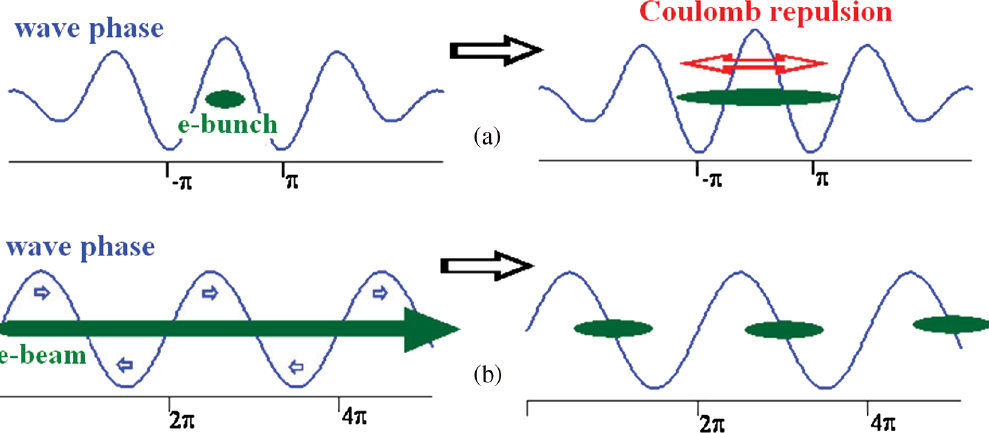
FIG. 1. (a) Spontaneous emission from a short electron bunch, as well as the termination of this process due to the increase in the phase size of the bunch caused by Coulomb repulsion. (b) Induced emission from a long electron beam of a traditional electron maser, which is based on the bunching of the beam in the field of the radiated